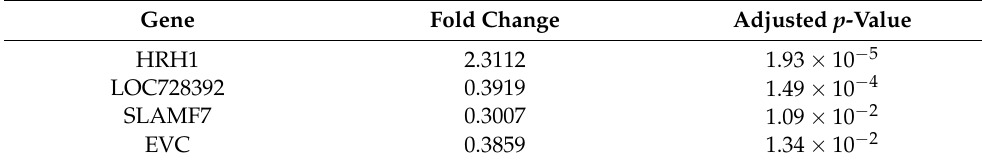
Table 3. Subtype-specific methylated genes with significantly different RNA expression levels.